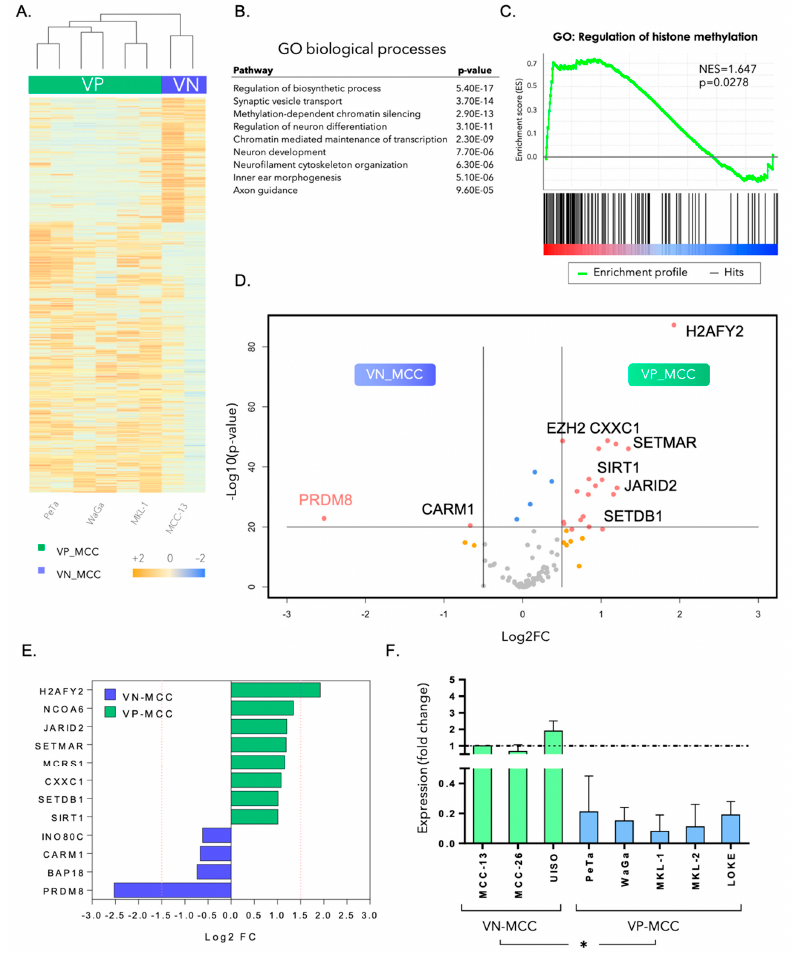
Figure 1. ( A ) Heatmap of the di ff erentially expressed genes (DEGs) in virus-negative (VN) versus virus-positive (VP) Merkel cell carcinoma (MCC) cell lines. Color scale bar shows expression fold change. ( B ) Pathway analysis shows deregulated pathways in two subtypes of MCC. Methylation-dependent chromatin silencing and chromatin-mediated maintenance of transcription are among the top enriched Gene Ontology (GO) biological terms ( p -value 2.9 × 10 − 13 and 2.3 × 10 − 9 , respectively). ( C ) Gene set enrichment analysis (GSEA) shows di ff erential enrichment of regulation of histone methylation in two subtypes of MCC (NES = 1.647, p < 0.05). ( D ) Volcano plot shows expression level of histone-regulating genes in VN-MCC compared to VP-MCC. x -axis shows the Log2 fold change of gene expression in VP vs. VN and y -axis shows the − Log10 of the p -value. The upper left corner shows the top upregulated histone-modifier genes in VN-MCC, whereas the upper right corner shows upregulated histone-modifier genes in VP-MCC. ( E ) Bar plot shows the Log2 fold change of the top upregulated genes in VN-MCC (blue bars) and the top upregulated genes in VP-MCC (green bars). ( F ) Expression data for PRDM8 (the top upregulated gene in VN-MCC) assessed using quantitative PCR in three VN-MCC cell lines and five VP-MCC cell lines. * p -value <